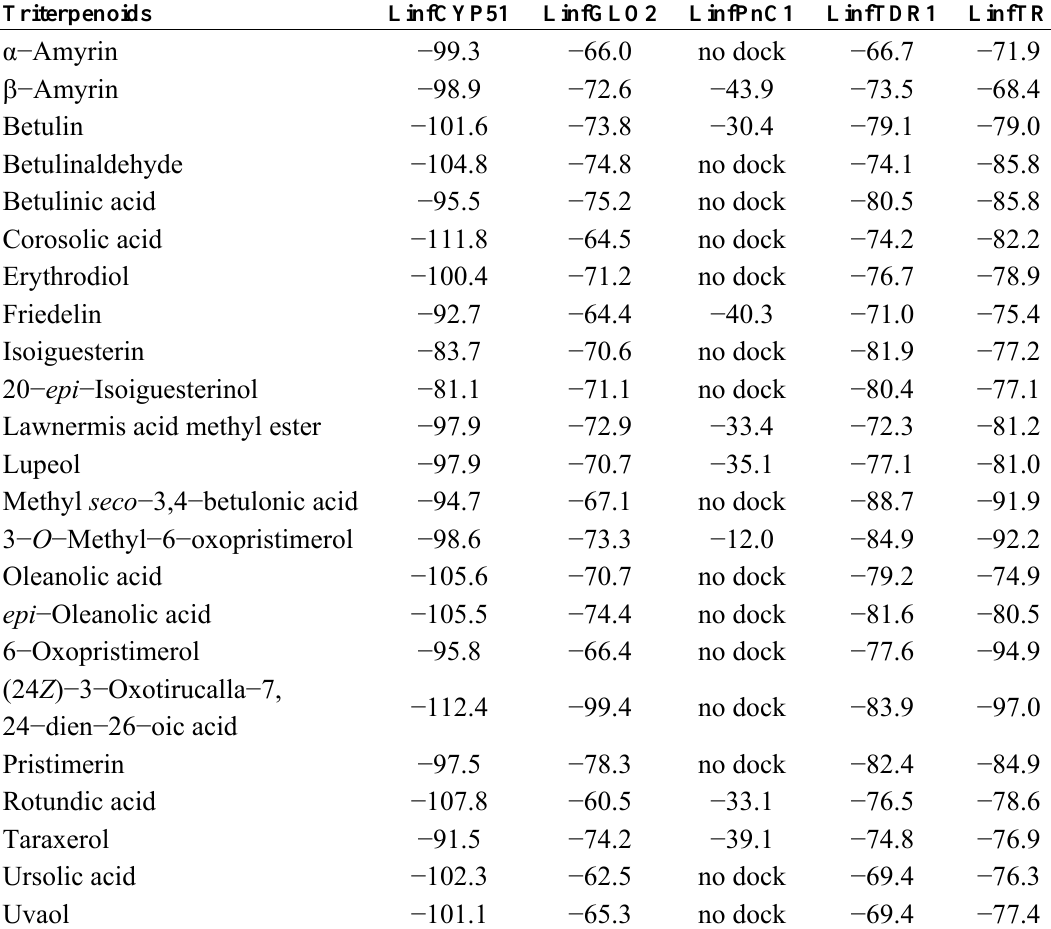
Table 37. MolDock docking energies (kJ/mol) of triterpenoids with Leishmania infantum protein